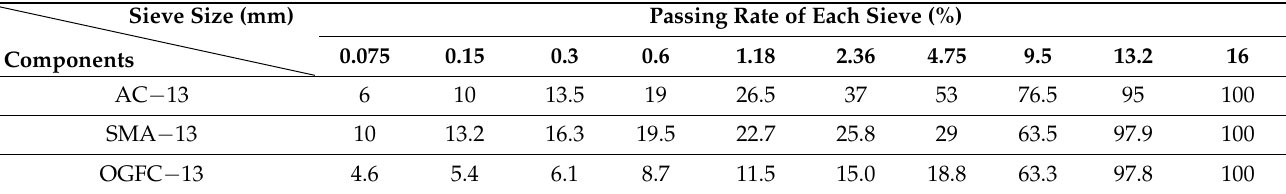
Table 1. Gradations for three kinds of asphalt pavement.